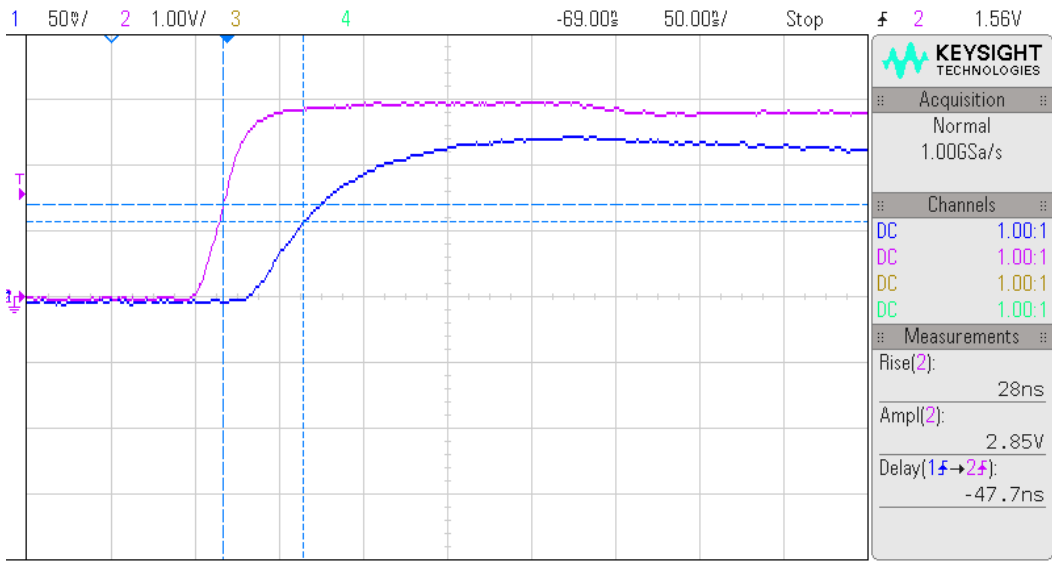
Figure 18. Settling time evaluation using envelope detector module. The pink color refers to the transient response of the supply voltage and the blue color refers to the LNA response signal with a delay of